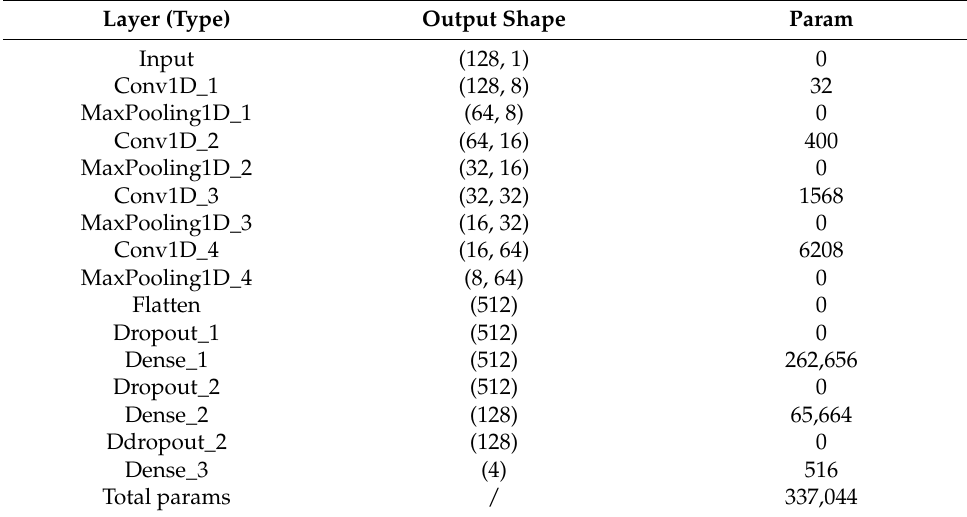
Figure 4. The structure of the DCNN used in this study. Table 2. The output shape and params of the the DCNN model.